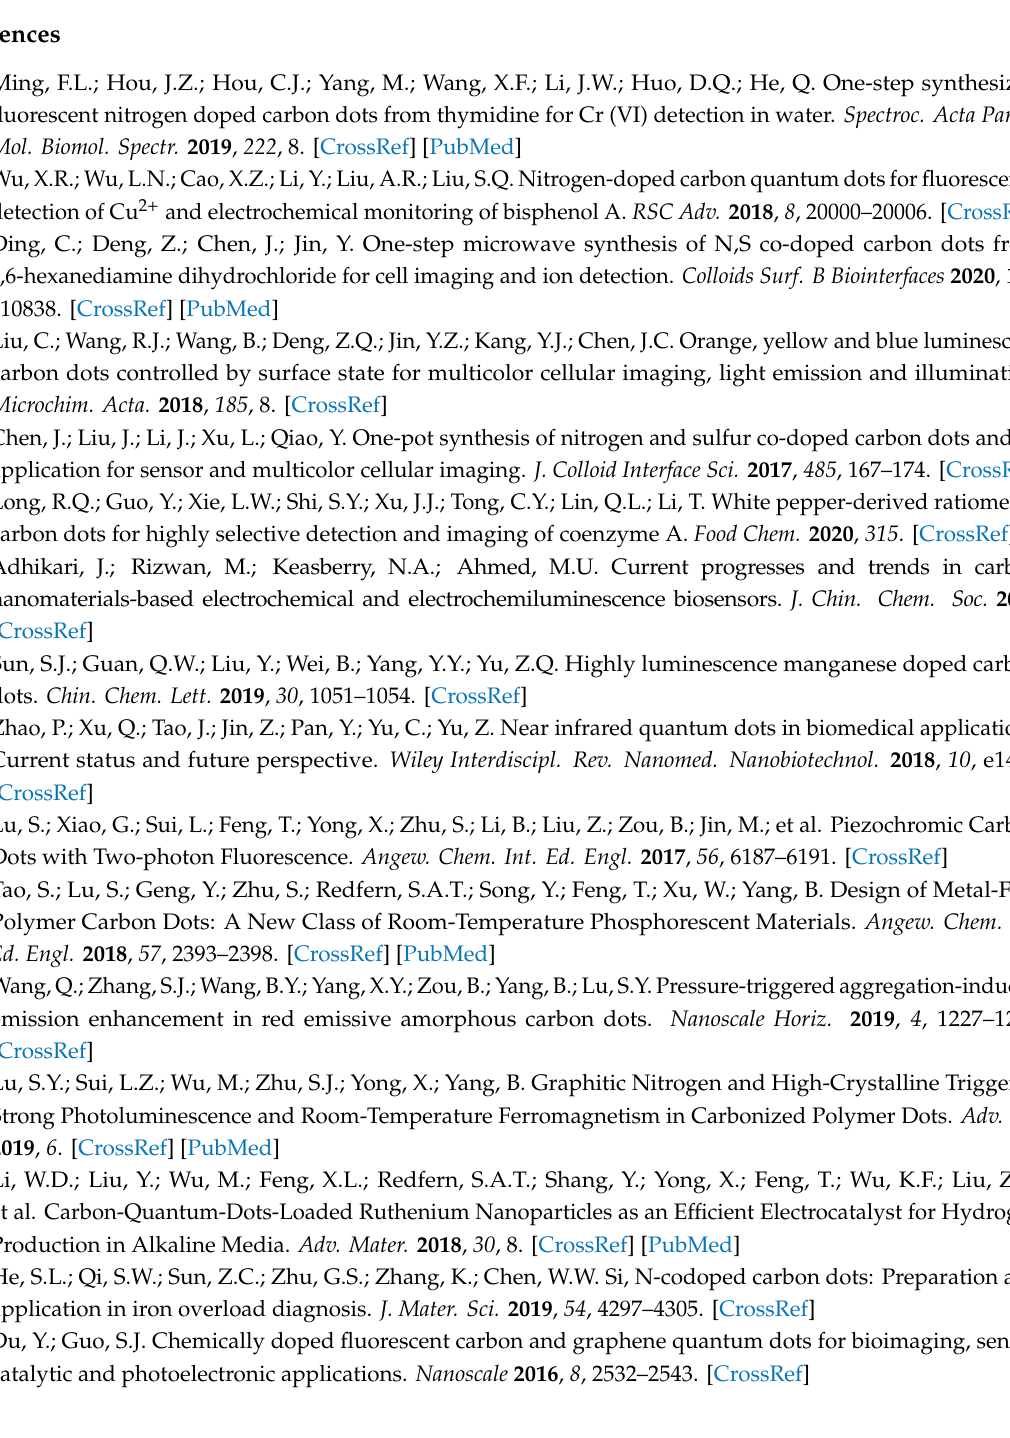
Figure S1: UV-vis absorption spectrum of NPCDs; Figure S2: Fluorescence spectra of the CDs at di ff erent excitation; Figure S3: Selectivity of NPCDs for assaying Fe 3 + . All metal cations have same concentration of 50 µ